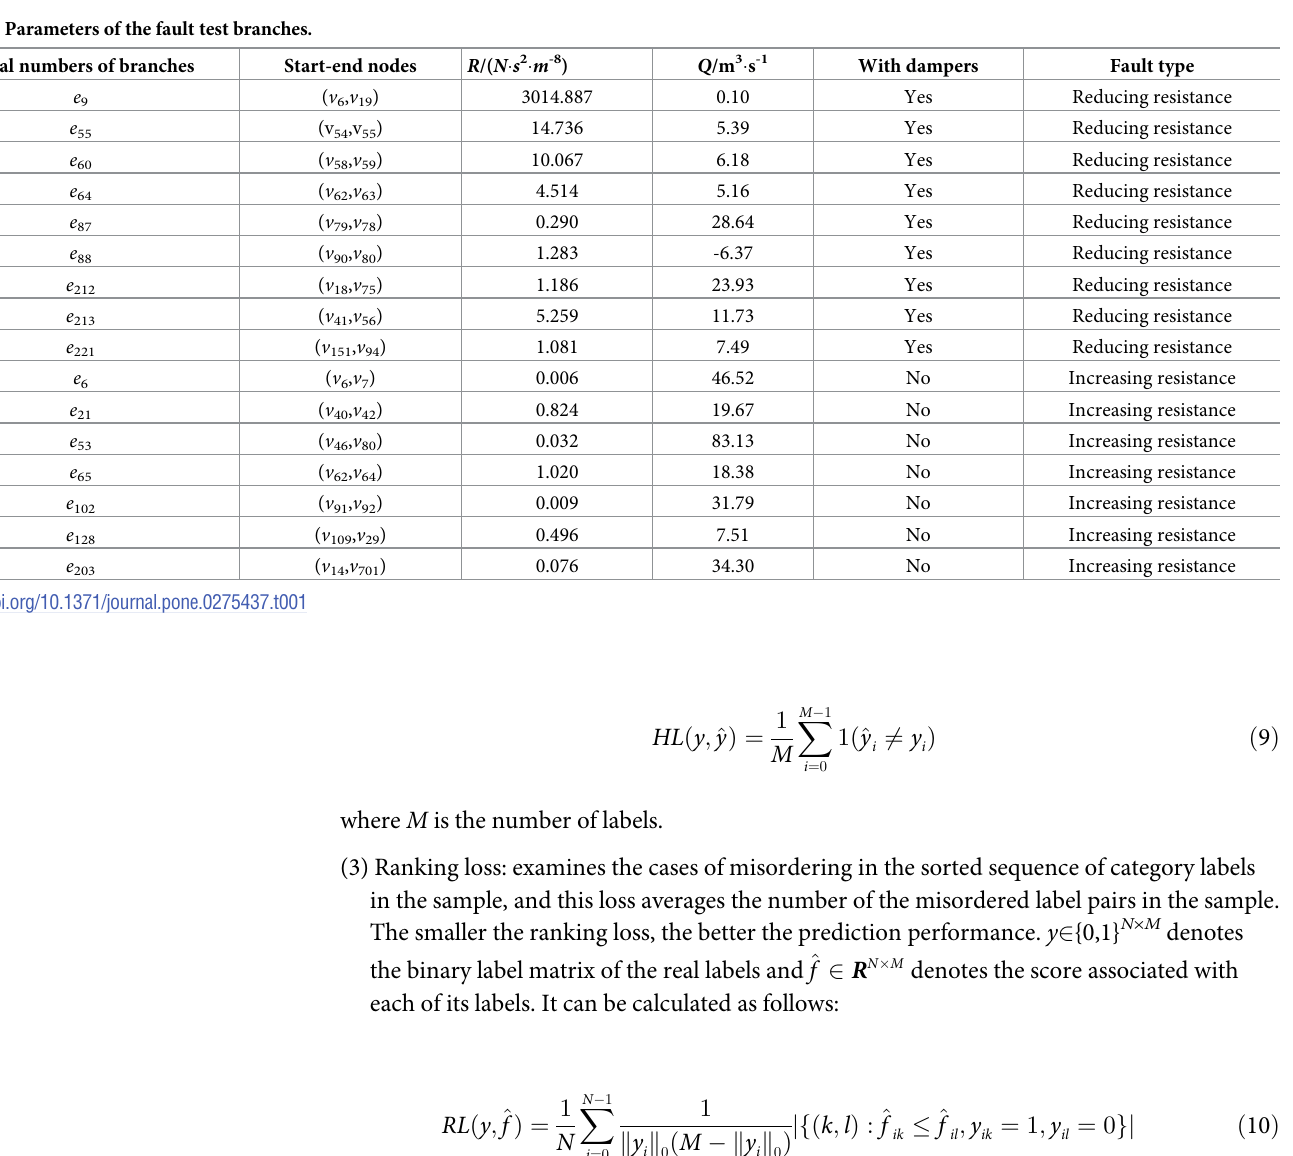
where | � | calculates the number of elements in the set and k�k zero elements in the vector.